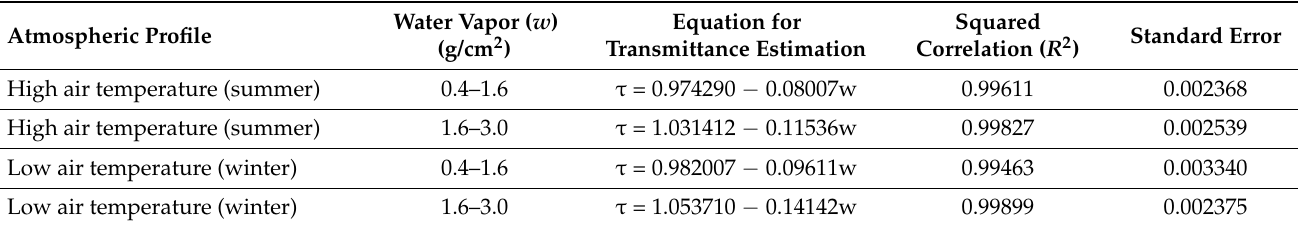
Table 2. Estimation equations of atmospheric transmittance.